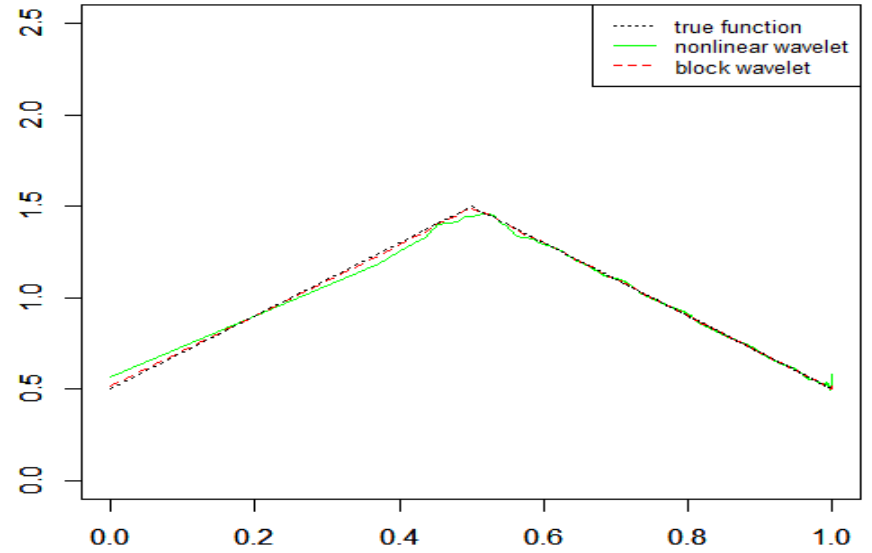
Figure 2. Recovery of the density function for NA samples in Example 2 ( n = 2048).